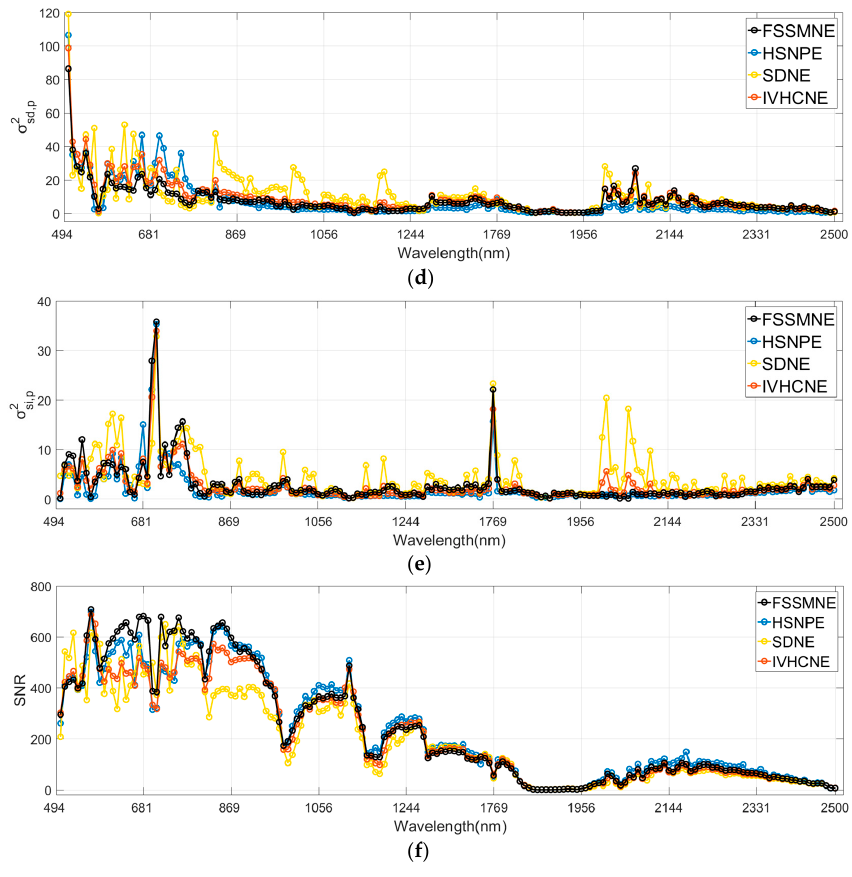
Figure 11. Noise estimates in each band of the real HS image using the FSSMNE, HSNPE, SDNE, and IVHCNE methods. ( a ) Estimates of the SD noise variance with Data Set 1; ( b ) estimates of the SI noise variance with Data Set 1; ( c ) estimates of the SNR with Data Set 1; ( d ) estimates of the SD noise variance with Data Set 2; ( e ) estimates of the SI noise variance with Data Set 2; ( f ) estimates of the SNR with Data Set 2. Table 4. Averaged Euclidean distances of noise estimates between Data Sets 1 and 2 with different methods.